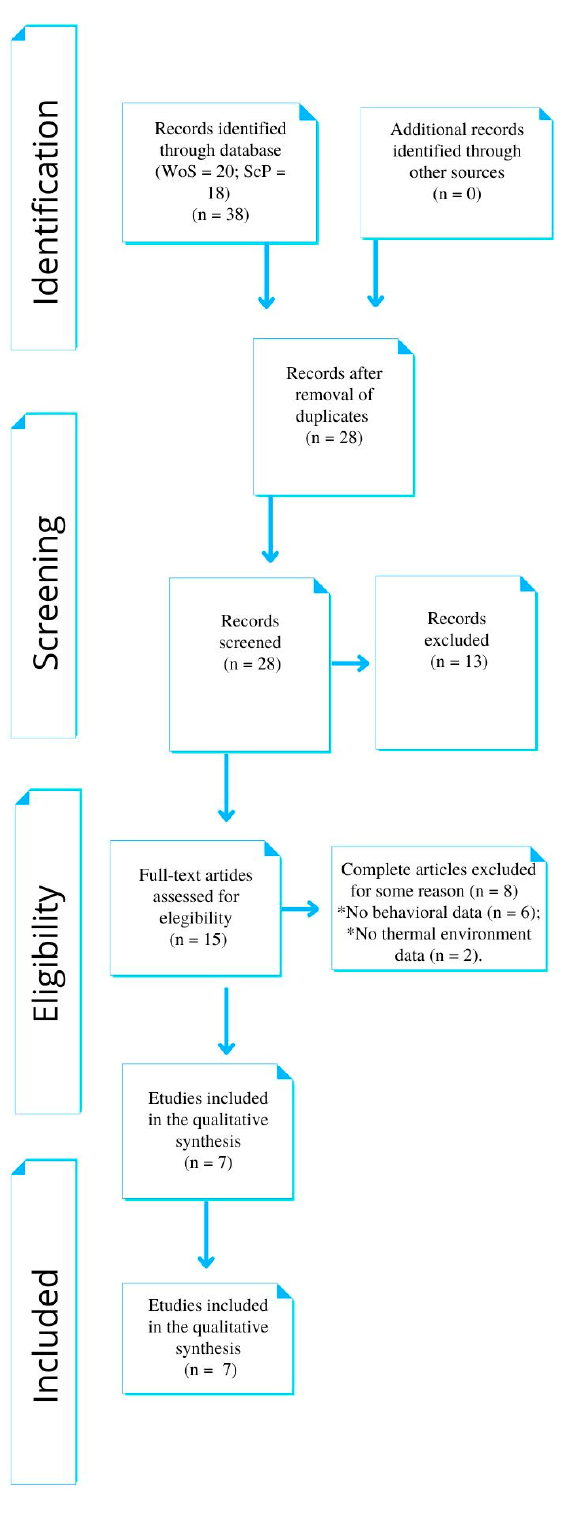
Figure 2. Flowchart following PRISMA guidelines (Moher et al. [35]) showing the total number of publications identified and the number of publications filtered at each stage of the selection process from the systematic review.